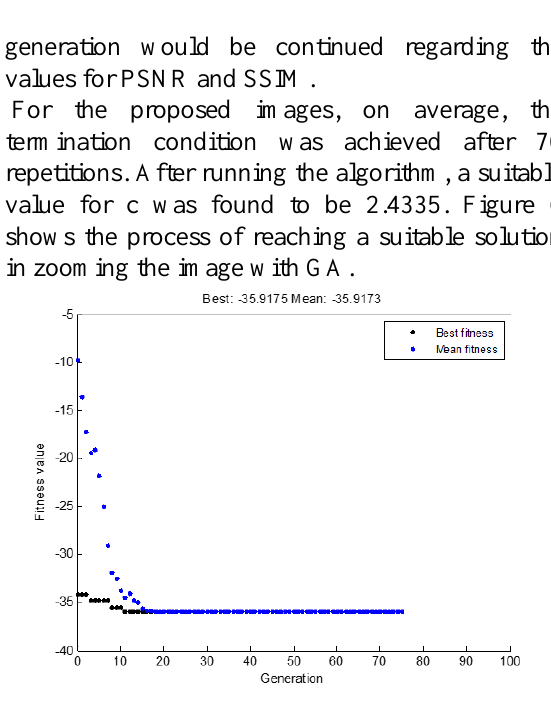
Figure 6. Process of reaching a suitable solution using GA and GRBF in image of lifting